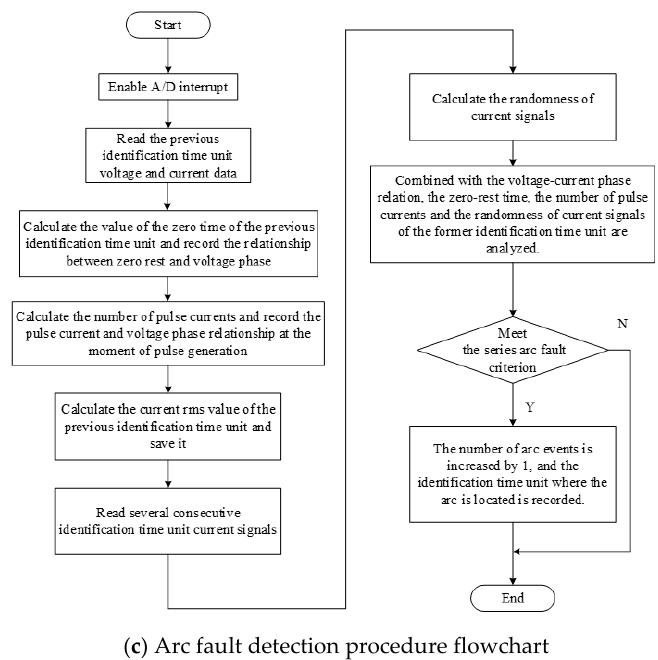
Figure 11. Flowchart of series arc fault detection method.